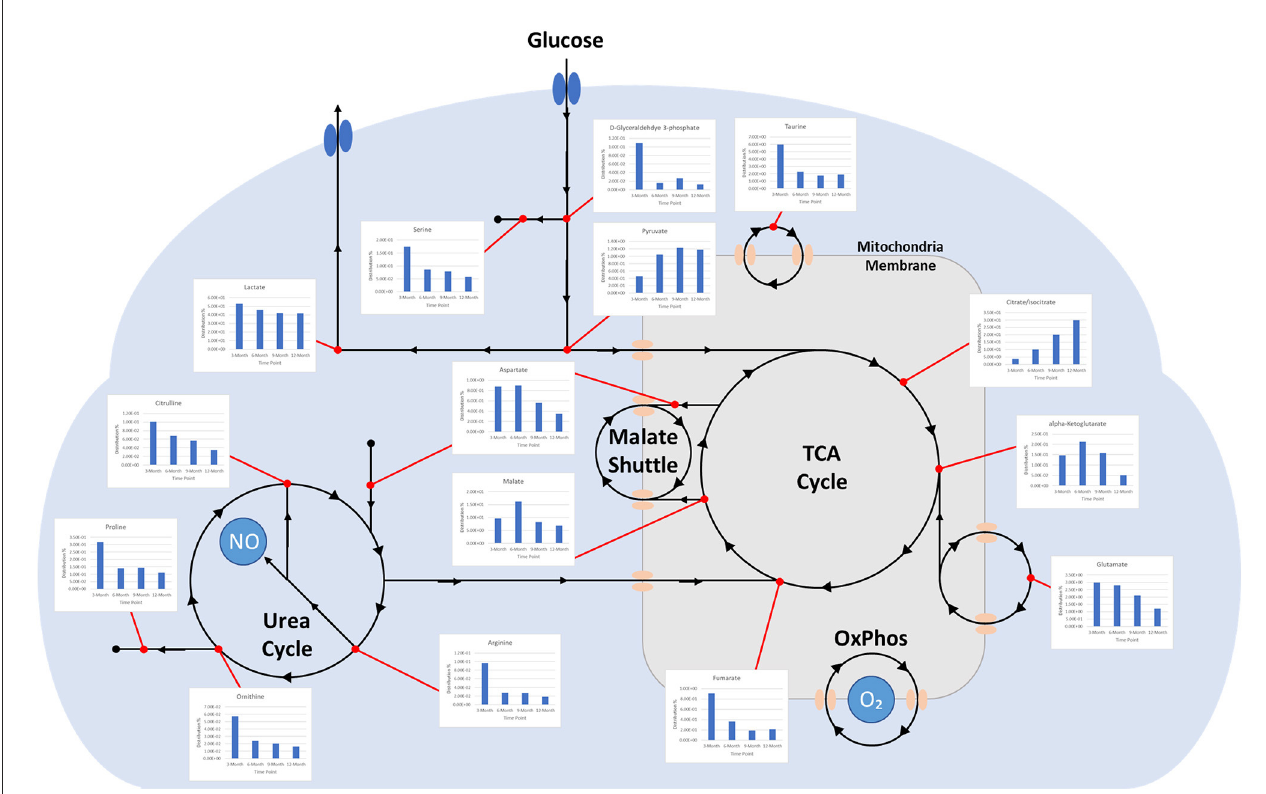
FIGURE10 Diagram depicting time-dependent small molecule normalized abundances as related to glycolysis. (1) Early enhanced lactate levels are indicative of conditions conducive to osteoblastic differentiation and activity. (2) Early enhanced levels of arginine may be indicative of angiogenic activity through the production of nitric oxide. (3) Early enhanced proline levels are indicative of collagen deposition to form soft callus tissue. (4) Increasing citrate/isocitrate and pyruvate levels are indicative of a switch to the TCA cycle for energy production and subsequent mineralization of tissue. (5) Decreasing taurine levels are indicative of more conducive environment for osteoclastic differentiation and may represent a move toward more homeostatic